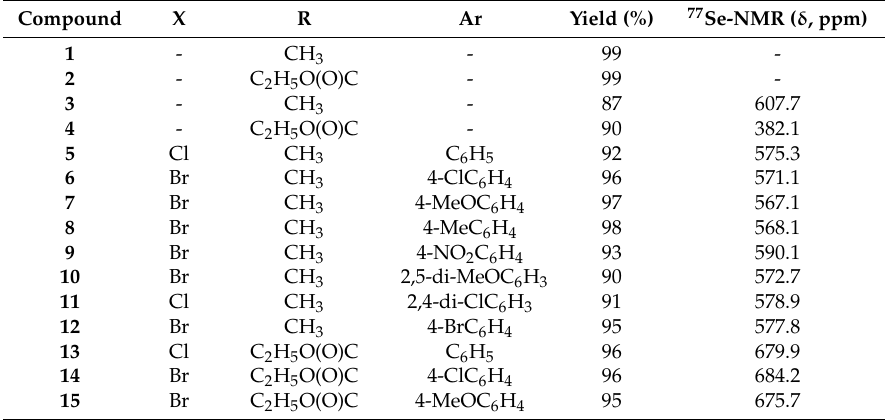
Table 1. Definition of the X, R and Ar Groups, Yields and 77 Se-NMR Data for Compounds 5 – 15 .